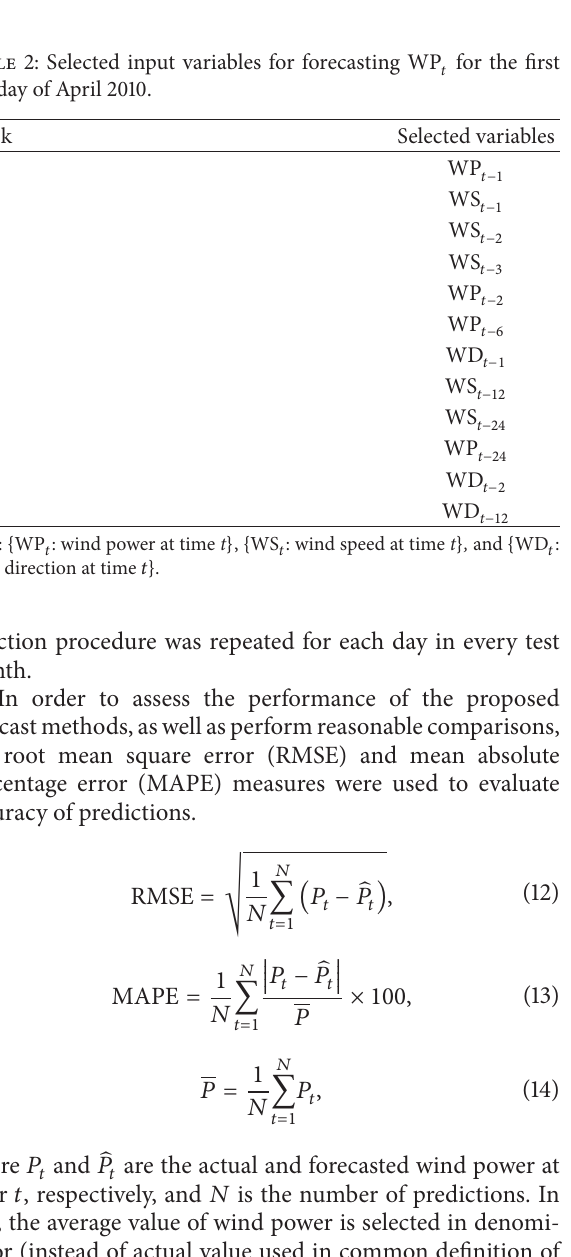
to the forecast day) was picked up as the validation data set.